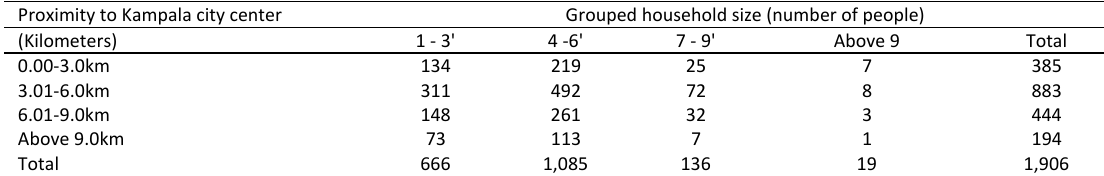
Table 2: Distribution of Household Size by Proximity to the City Centre